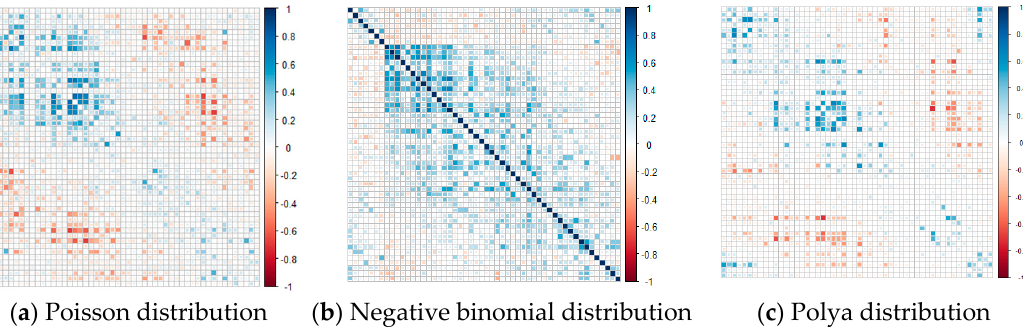
Figure 5. Correlation coefficient matrix of posterior parameters of three different distributions.